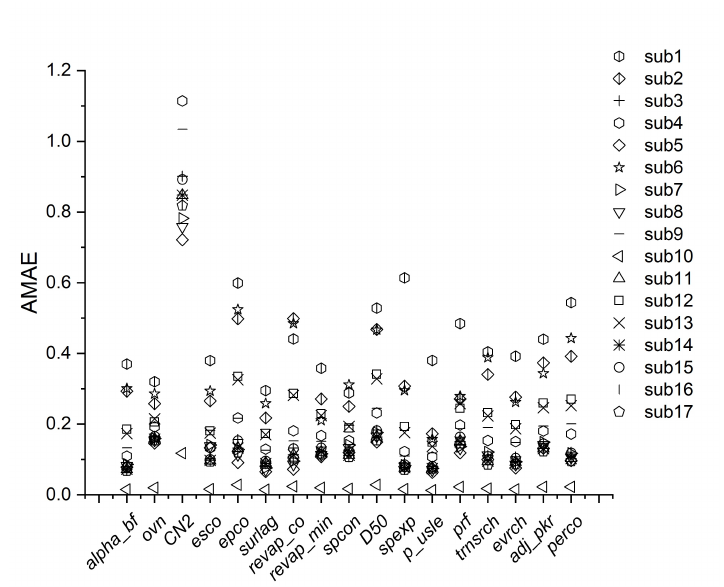
Figure 12. AMAE index for Q surf of the model parameters.